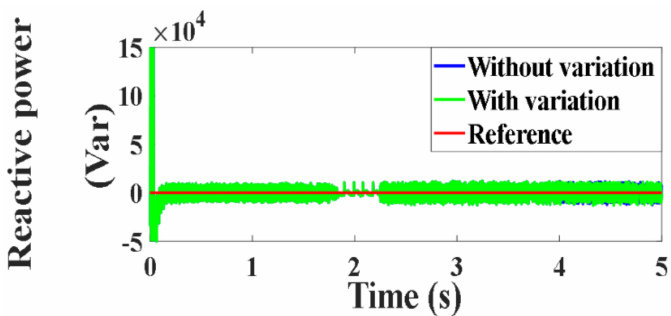
Figure 68. Reactive power under PVC (var).